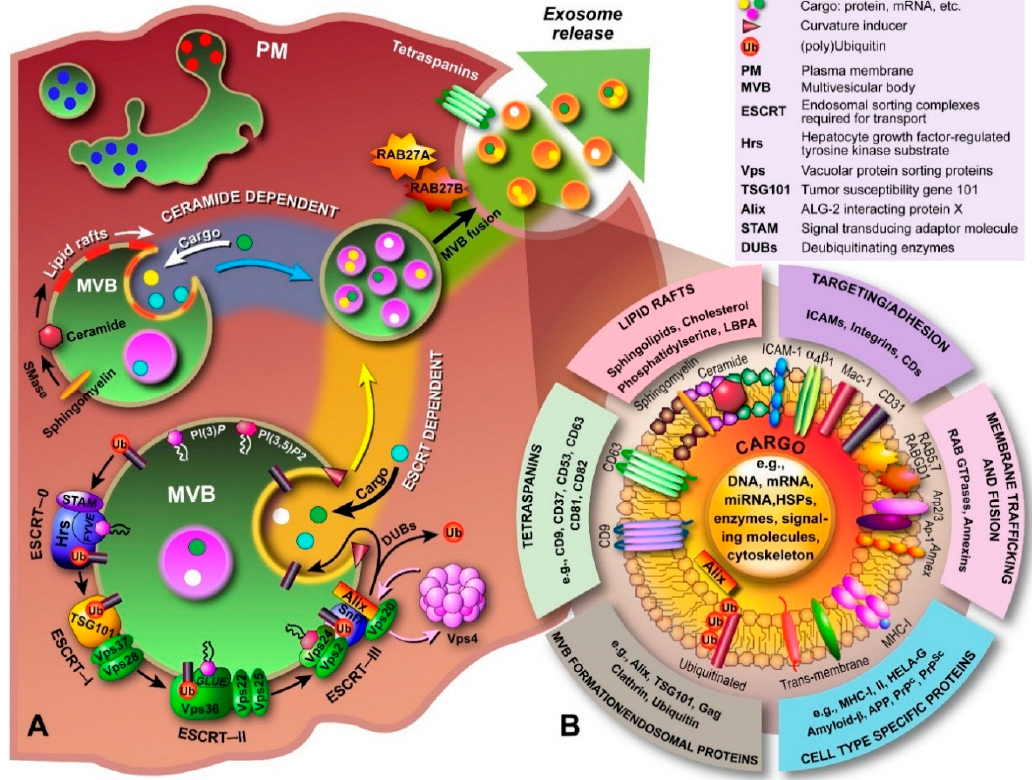
Figure 3. Biogenesis, secretion and composition of exosomes. ( A ) The biogenesis and secretion of exosomes is believed to be mediated via a ceramide and/or ESCRT-dependent pathway. The ceramide-dependent pathway is based on the formation of lipid rafts in which sphingomyelin is converted to ceramide by sphingomyelinases. These ceramide-enriched domains have structural imbalances between monoleaflets causing the membrane to bend inward. In the ESCRT-dependent pathway, components of the ESCRT machinery are sequentially recruited to the endosomal membrane, which starts with Hrs, and bind to phosphatidylinositol-3-phosphate (PI(3) P ) and the 3,5-bisphosphate (PI(3,5) P 2) through lipid binding domains (e.g., FYVE , GLUE ), and to the ubiquitinated protein (ESCRT-0). ESCRT-I and -II drive budding of ILVs, during which cargo is transported into the lumen, and ESCRT-III is recruited by Alix to complete budding and drive vesicle scission (spiral formation and pulling). DUBs deubiquitinate the protein and Vps4 recycles the ESCRT machinery. The now formed MVB is transported to the PM and through fusion, the ILVs are released into the extracellular environment and are now called “exosomes”; ( B ) Exosomal luminal cargo predominantly consists of mRNA, miRNA and gDNA fragments, and a myriad of different proteins depending on the cell of origin. Generally, proteins involved in MVB formation, tetraspanins, membrane transport and fusion, transmembrane proteins, cytoskeletal components and proteins of cytosolic origin are part of exosomes. In addition, biomolecules associated with various diseases, including cancer, neurodegenerative diseases, such as Parkinson’s, Alzheimer’s and transmissible spongiform encephalopathies (prion disease), and inflammatory disorders have been identified in exosomes.